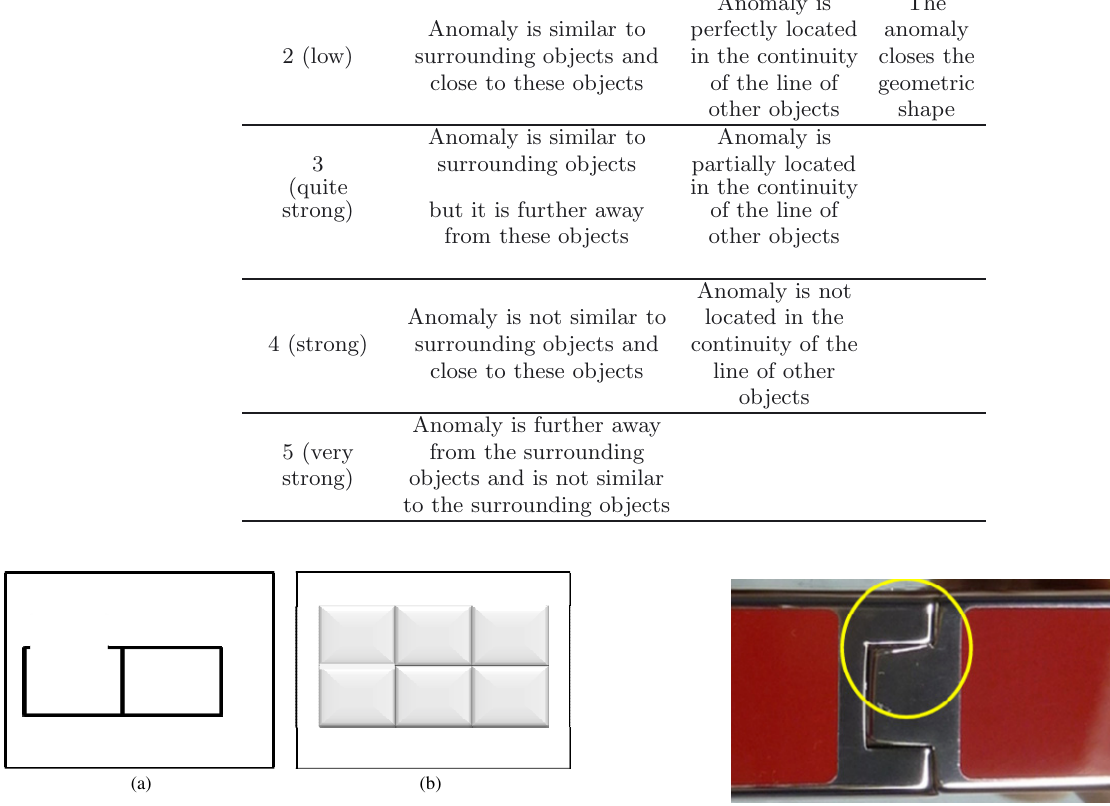
Fig. 14. Law of closure.